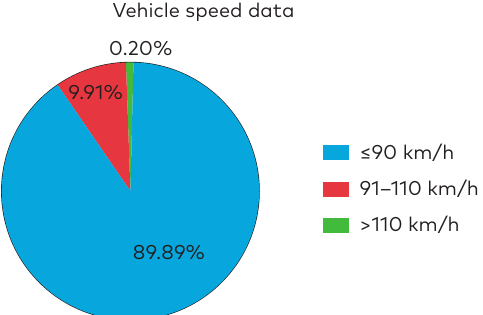
Figure 5. Speed data recorded by the average speed enforcement systems in